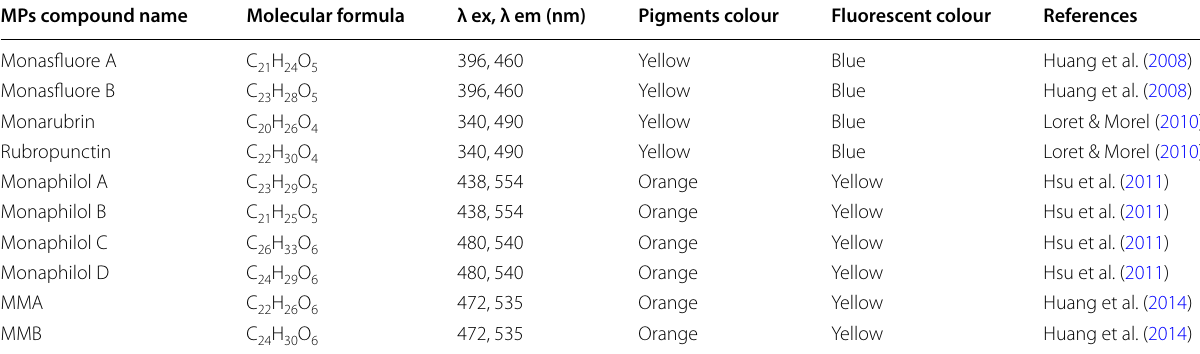
Table 1 Summary of the reported Monascus pigments with